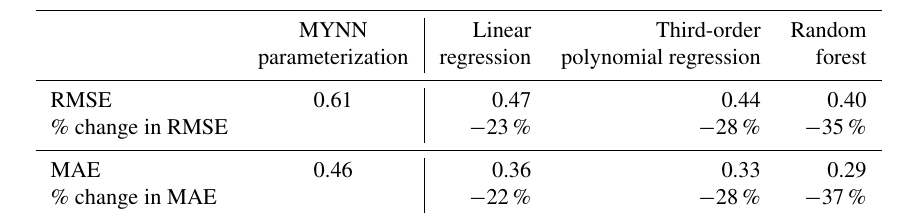
Table 3. Performance of the machine-learning algorithms trained and tested at Perdigão, measured in terms of RMSE and MAE between the logarithm of observed and MYNN-parameterized (cid:15) .